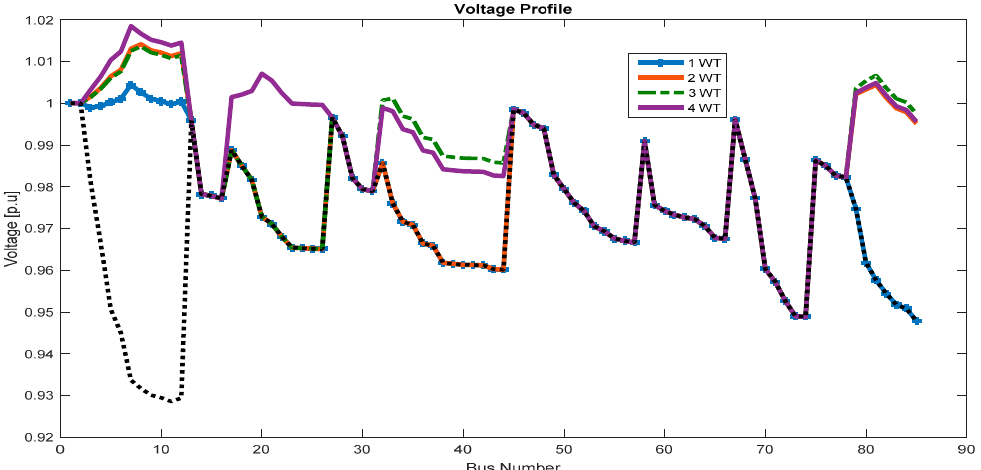
Table 2. Results of optimal site selection of turbines without considering constraints (multi-objective).